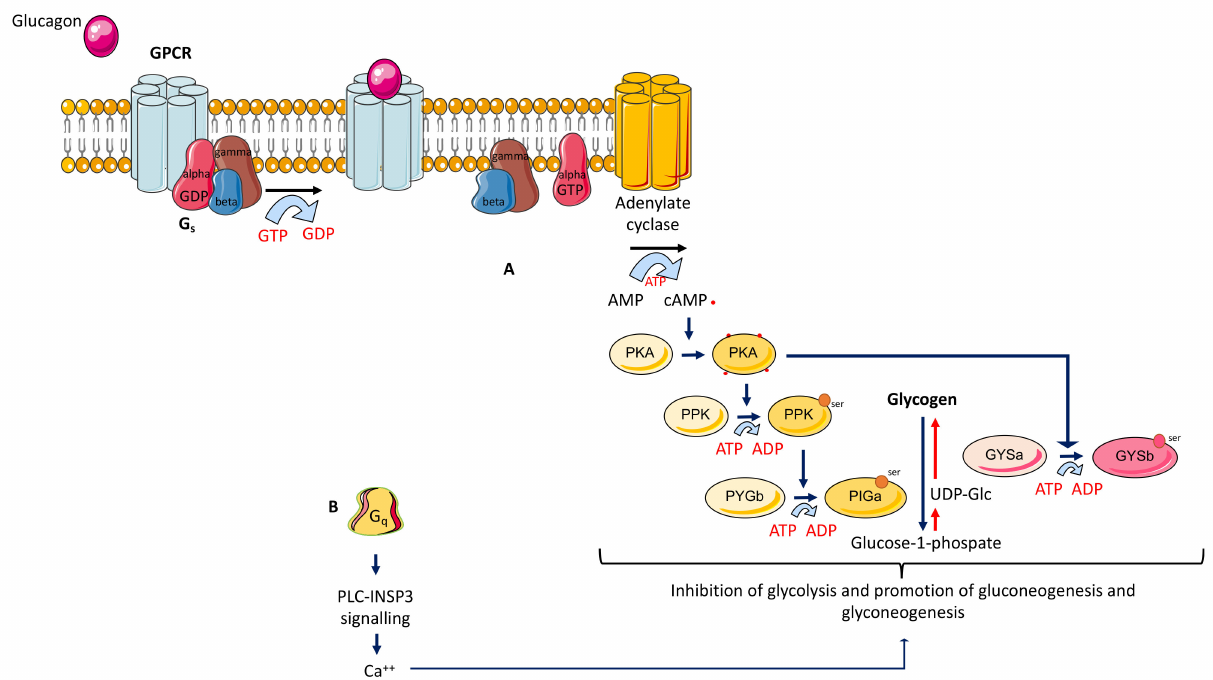
Figure 1. Depiction of glucagon signalling. The glucagon signaling pathway promotes glycogenolysis and gluconeogenesis, resulting in a significant increase in blood glucose. Glucagon (red ball) binds to G protein-coupled receptor (GPCR) and provides a conformational status that activates G proteins. ( A ) The heterotrimeric G-proteins with α , β , and γ subunits, interact with the receptor, and replace the GDP molecule (to the α subunit) with a GTP molecule. Thus, α subunit leaves the β and γ subunits, and specifically activates adenylate cyclase. The latter catalyzes the conversion of ATP to cAMP (cyclic Adenosine Mono Phosphate), which binds to protein kinase A (PKA). PKA, a cAMP-dependent protein kinase, phosphorylate a single serine residue of the bifunctional polypeptide chain containing both the enzymes fructose 2,6- bisphosphatase and phosphofructokinase-2. This regulates the reaction catalyzing fructose 2,6-bisphosphate (a potent activator of phosphofructokinase-1, the enzyme that is the primary regulatory step of glycolysis) by slowing the rate of its formation, thereby inhibiting the flux of the glycolysis pathway and allowing gluconeogenesis to predominate. The inactive form of glycogen phosphorylase b (PYG b) undergoes phosphorylation, allowing it to convert into the active form, phosphorylase a (PYG a), which releases glucose 1-phosphate from glycogen polymers. ( B ) The binding with a subunit Gq leads to activation of the phospholipase-C (PLC)-inositol 3 phosphate (I3P) pathway, inducing the release of Ca ++